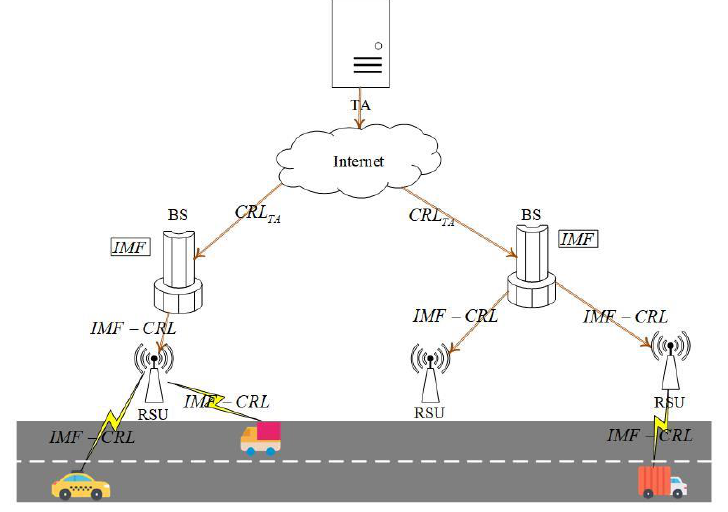
Figure 3. IMF-PR system